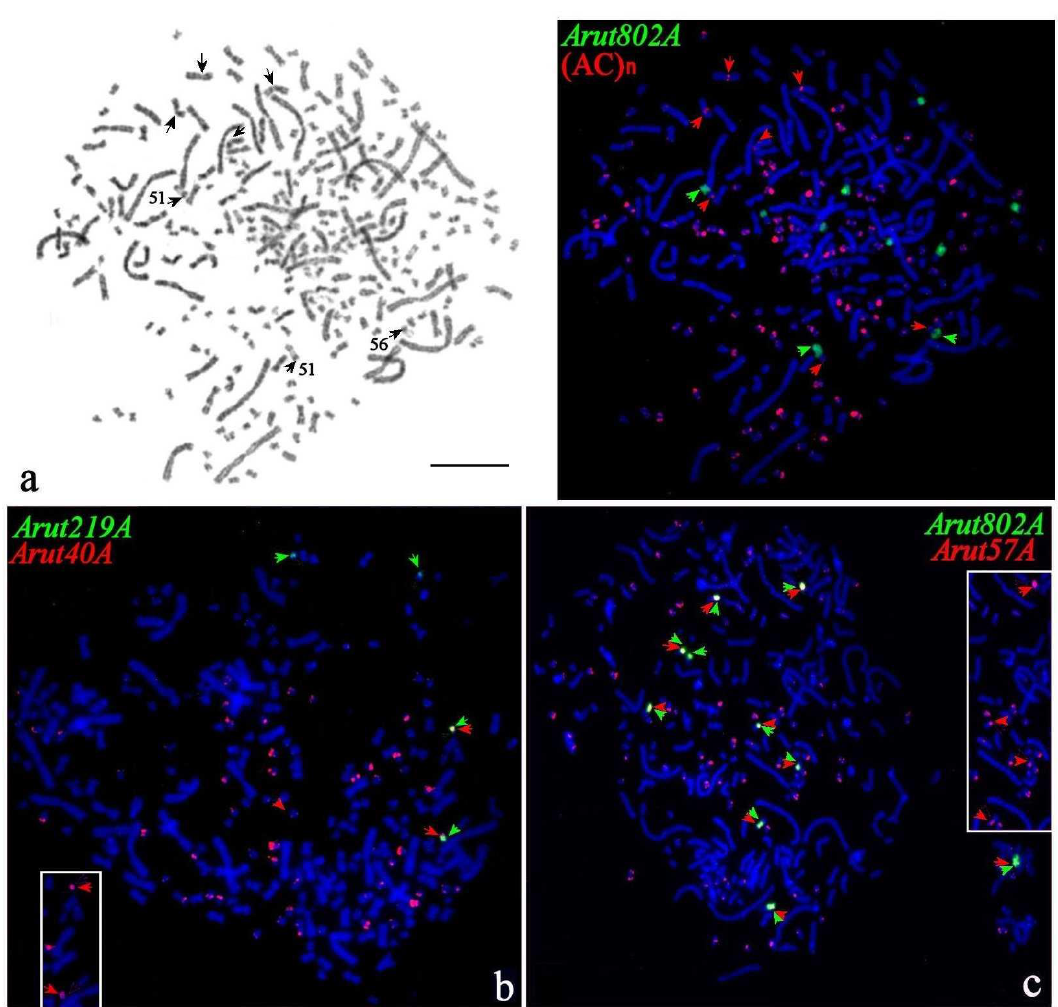
Figure 4. FISH of repetitive DNA probes on metaphase plates of the Siberian sturgeon ( a–d ). ( a ) Satellites (AC) n (red) and Arut802A (green) on GTG-banded metaphase plate ( left ). Arrows mark four middle-size metacentric chromosomes and NOR-bearing chromosomes with dual signals; ( b ) satellites Arut40A (red) and Arut219A (green), arrows mark chromosomes with dual signals; ( c ) satellites Arut57A (red) and Arut802A (green), arrows mark NOR-bearing chromosomes with dual signals, in the right insert the part of the plate is represented only with Arut57A. The scale bar is 10 µm.